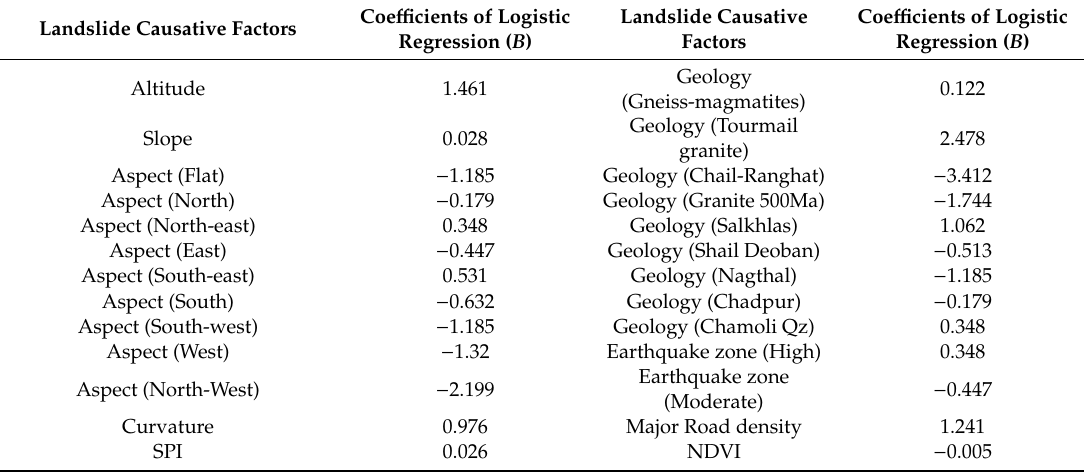
Figure 11. Weights of landslide causative factors calculated by RF. Table 6. Logistic regression coefficients of landslide causative factors.